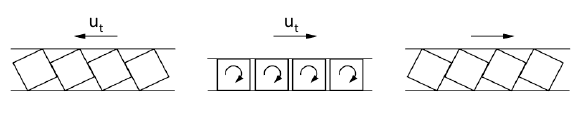
Figure 8: Configurational rearrangement of particles after the change of sliding direction